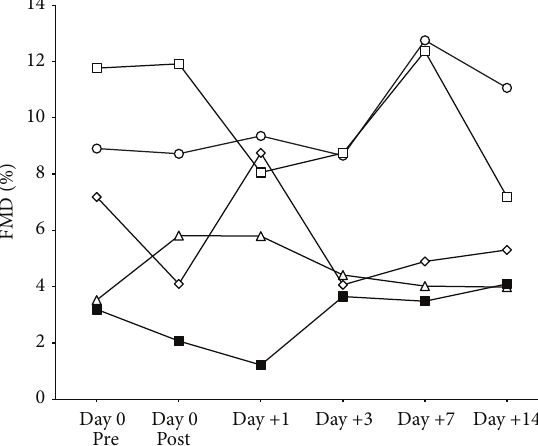
Figure 2: Individual changes in brachial artery flow-mediated dila- tion (FMD) measured prior to (Pre) and following LDL apheresis